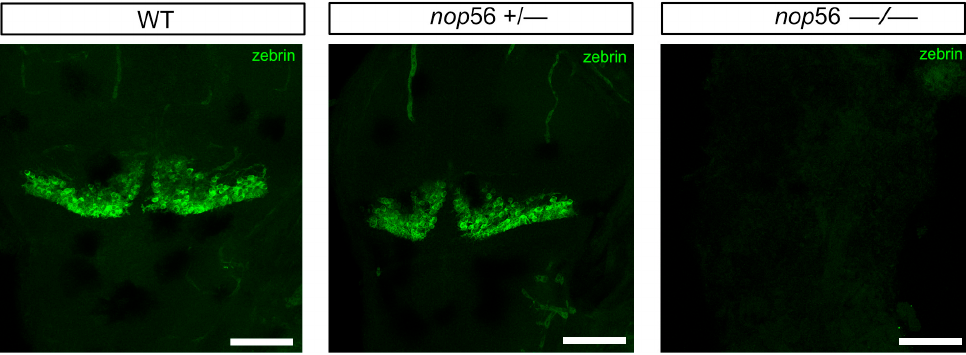
Figure 5. Zebrin II immunofluorescence in 4 dpf zebrafish larvae revealed a complete lack of cerebellar Purkinje cells in nop56 − / − . Dorsal views. Anterior to the top. Scale bar: 150 μ m.